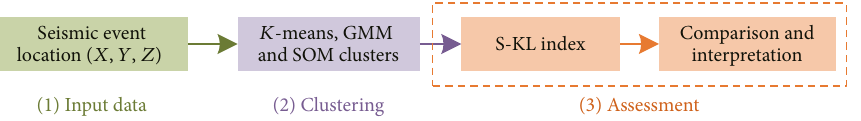
Figure 1: General outline of this